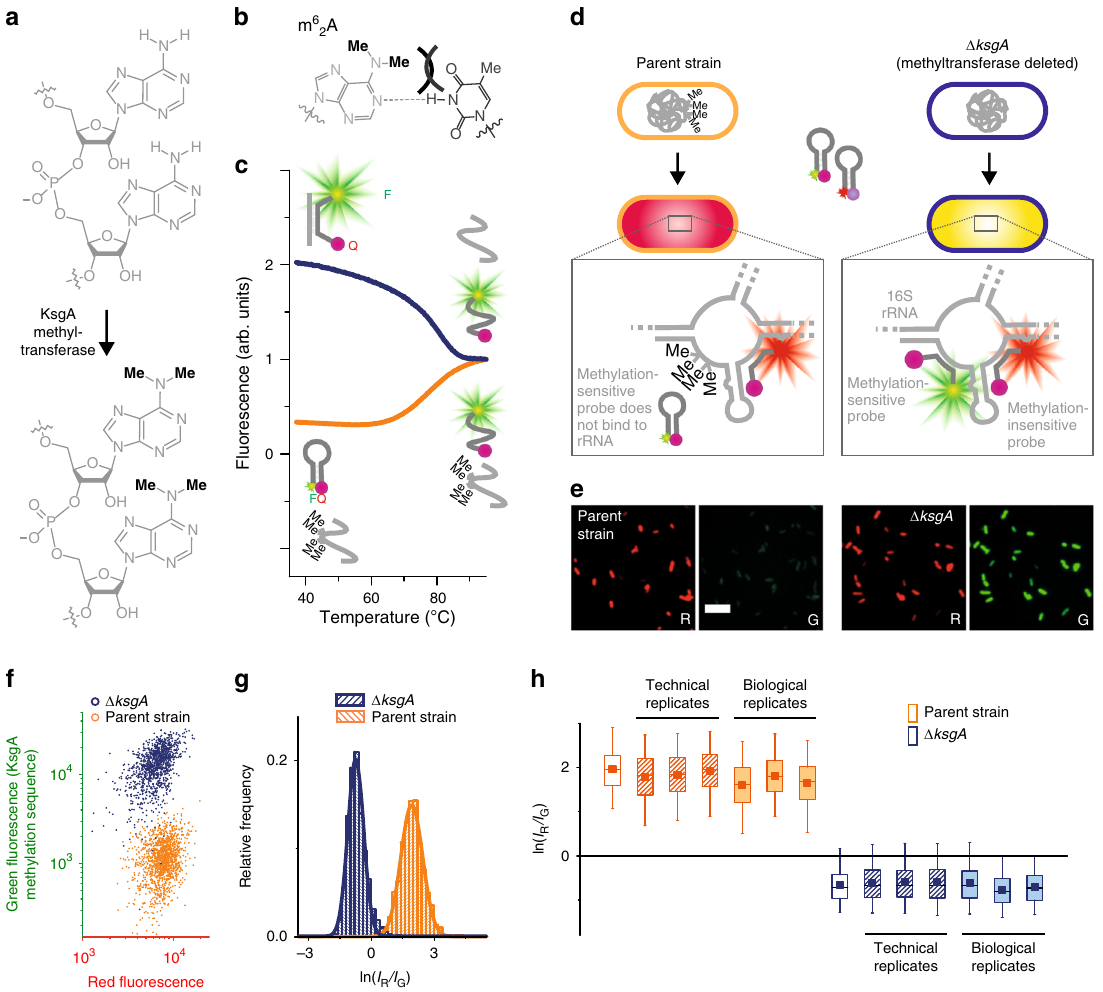
Fig. 1 Destabilized base pairing by methylated RNA enables detection of post-transcriptional modi fi cation in single cells. a N 6 -Dimethylation of A1518 and A1519 in 16S rRNA catalyzed by KsgA. b N 6 -Dimethyladenine (m 6 2 A) is sterically inhibited from base pairing with thymine. c A Molecular Beacon can discriminate between methylated and unmethylated synthetic RNA, as revealed by in vitro thermal melting. d MR-FISH assay for rRNA methylation, using two Molecular Beacons and two strains of E . coli :, one expressing active KsgA (parent strain) and one mutant strain with the methyltransferase deleted from its genome ( Δ ksgA ). e Fluorescence images showing that Δ ksgA E . coli are stained red and green by MR-FISH probes, while parent strain cells are brightly stained only by the methylation-insensitive red probe. Scale bar: 10 μ m. f Scatter plots of red and green fl uorescence intensities of parent strain ( n = 1315 cells) and Δ ksgA ( n = 1112 cells) bacteria stained by MR-FISH. g Log-normally distributed ratios of red fl uorescence intensity ( I R ) to green fl uorescence intensity ( I – 75th percentiles; whiskers: 5th – 95th percentiles; horizontal line: G ) of bacteria stained by MR-FISH. h Box plots (box: 25th medians; squares: means) of two-color ratios shown in ( g ) (empty bars), as well as technical replicates (hatched bars) and biological replicates ( fi lled bars). From left to right, n = 1315, 1056, 1173, 1115, 865, 1253, 927, 1110, 1291, 1523, 1374, 1118, 850 and 988 cells per